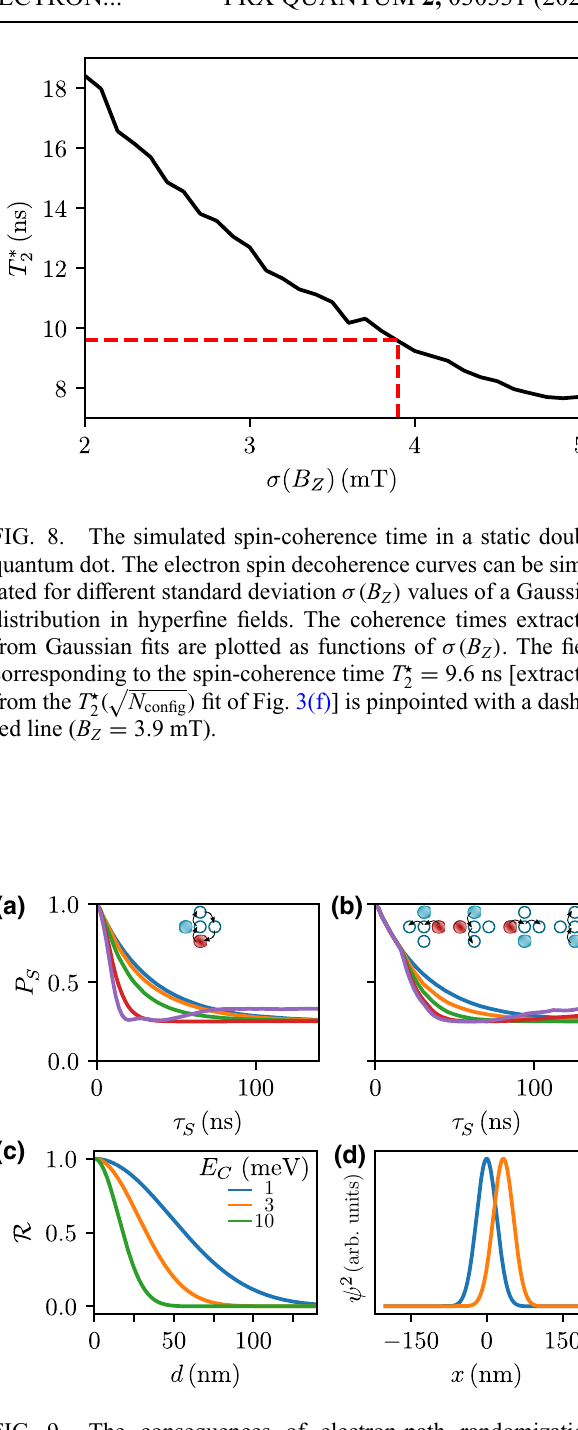
FIG. 9. The consequences of electron-path randomization. (a),(b) Simulated decoherence decay curves for (a) one and (b) two displaced electrons for different values of the remanence parameter R : 0 (blue), 0.5 (orange), 0.7 (green), 0.9 (red), and 1 (purple). (c) The estimated remanence R plotted as a function of the distance between the dot locations of two consecutive peri- ods, for a charging energy of 1 (blue), 3 (orange), and 10 meV (green). (d) A cross-section view of the two-electron densities computed using the fundamental Fock-Darwin state [29] and separated by 33 nm ( R = 0.5), assuming a charging energy of 3 meV.